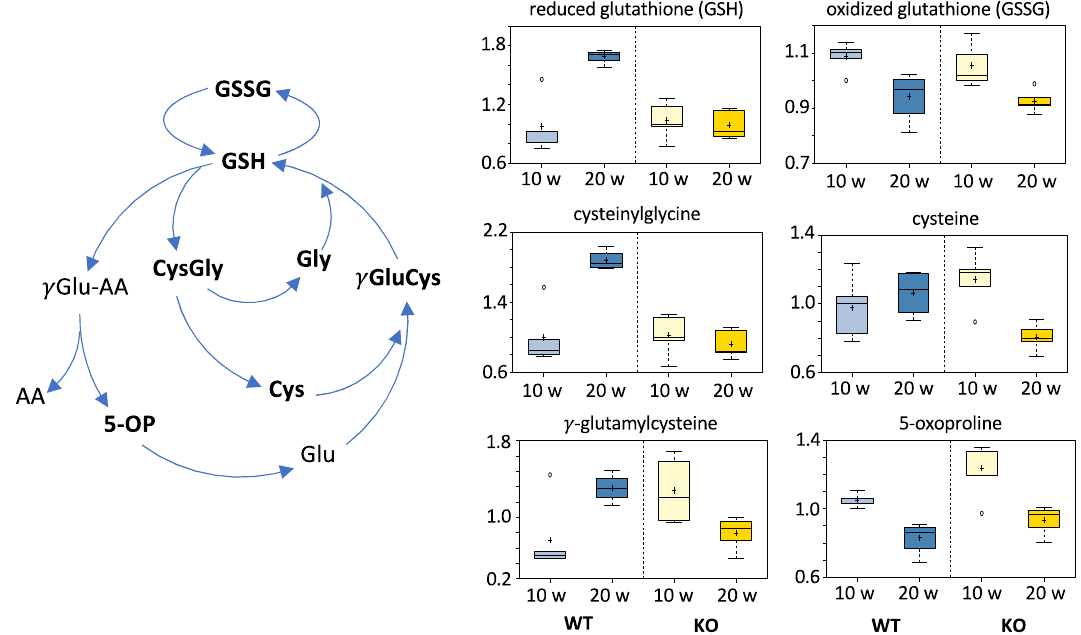
Figure 9. Glutathione cycle and comparative levels of relevant metabolites assigned by metabolomic analysis. Metabolites important to differentiation of the WT and KO mice are shown in boldface in the diagram. Y -axes of individual metabolite box plots represent scaled intensity. Measurements for each biochemical in the original scale were rescaled to set the median equal to 1.